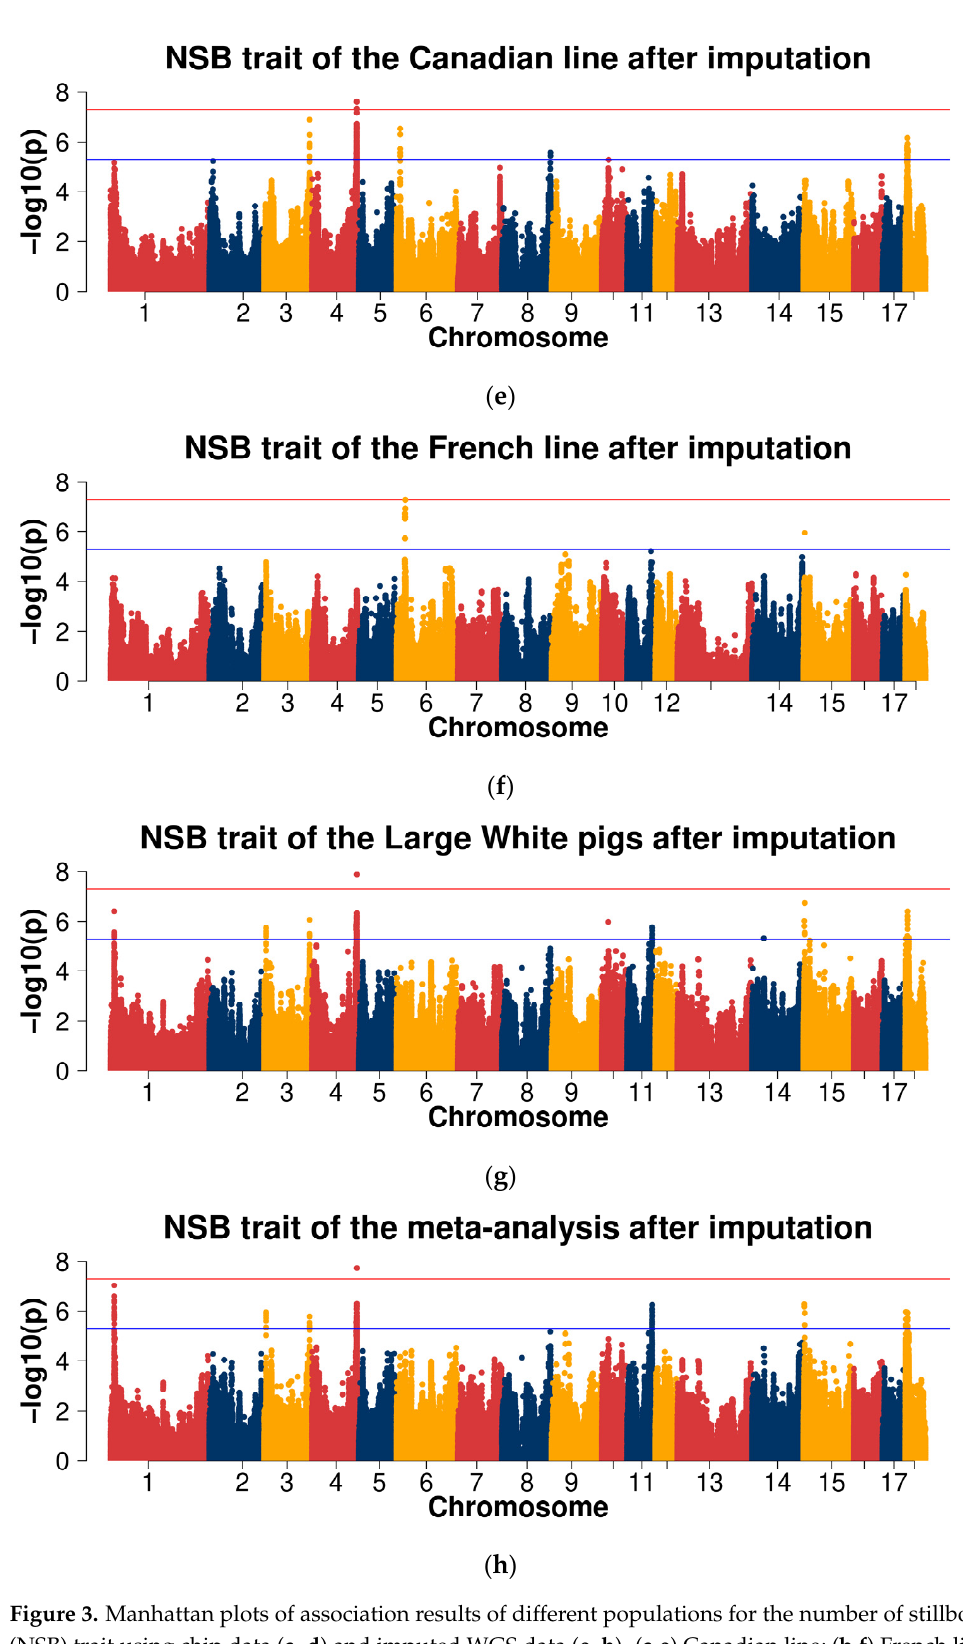
Figure 3. Manhattan plots of association results of different populations for the number of stillborn (NSB) trait using chip data ( a – d ) and imputed WGS data ( e – h ). ( a , e ) Canadian line; ( b , f ) French line; ( c , g ) combined lines of Large White pigs; ( d , h ) cross-population meta-analyses. For the GL trait, the Manhattan plots are shown in Figure 4a–d. Q-Q plots are shown in Supplementary Figure S4a–d, with genome inflation factors between 0.973 and 1.024